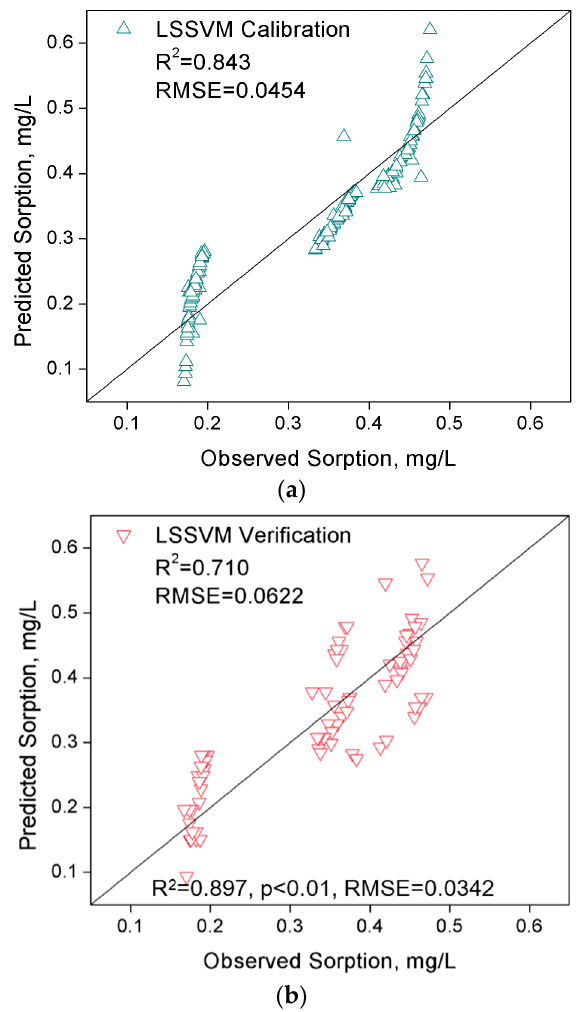
Figure 5. The calibration ( a ) and verification ( b ) of phenanthrene sorption data using the least squares support vector machines (LSSVM) method (Run No. 3). Table 2. Comparisons among SCA, LSSVM and random forest for the fitting of phenanthrene sorption data (Run No. 3).